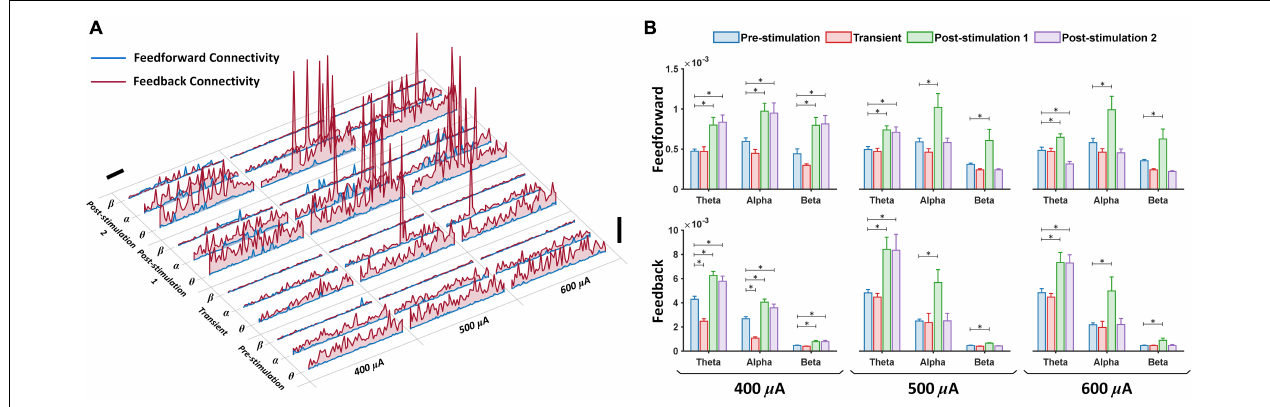
FIGURE 4 | Corticocortical directional connectivity enhancement following retinal electrical stimulation. (A) Time course of feedforward (blue lines) and feedback (red lines) directional connectivity for theta, alpha and beta bands, respectively, during pre-stimulation (10 min), transient stimulation (10 min), post-stimulation stage 1 (10 min) and post-stimulation stage 2 (10 min). Feedforward (left primary visual cortex to left prefrontal cortex) and feedback (left prefrontal cortex to left primary visual cortex); vertical scale bar, 0.01, horizontal scale bar, 100 sec. (B) The average feedforward (upper panel) and feedback (lower panel) directional connectivity at three frequency bands from 400 µ A stimulation ( n = 6), 500 µ A stimulation ( n = 6), 600 µ A stimulation ( n = 6) was computed during pre-stimulation (baseline), transient stimulation, post-stimulation stage 1 and post-stimulation stage 2. Feedforward (left primary visual cortex to left prefrontal cortex) and feedback (left prefrontal cortex to left primary visual cortex). ∗ Significant ( P < 0.025); Error bar denotes